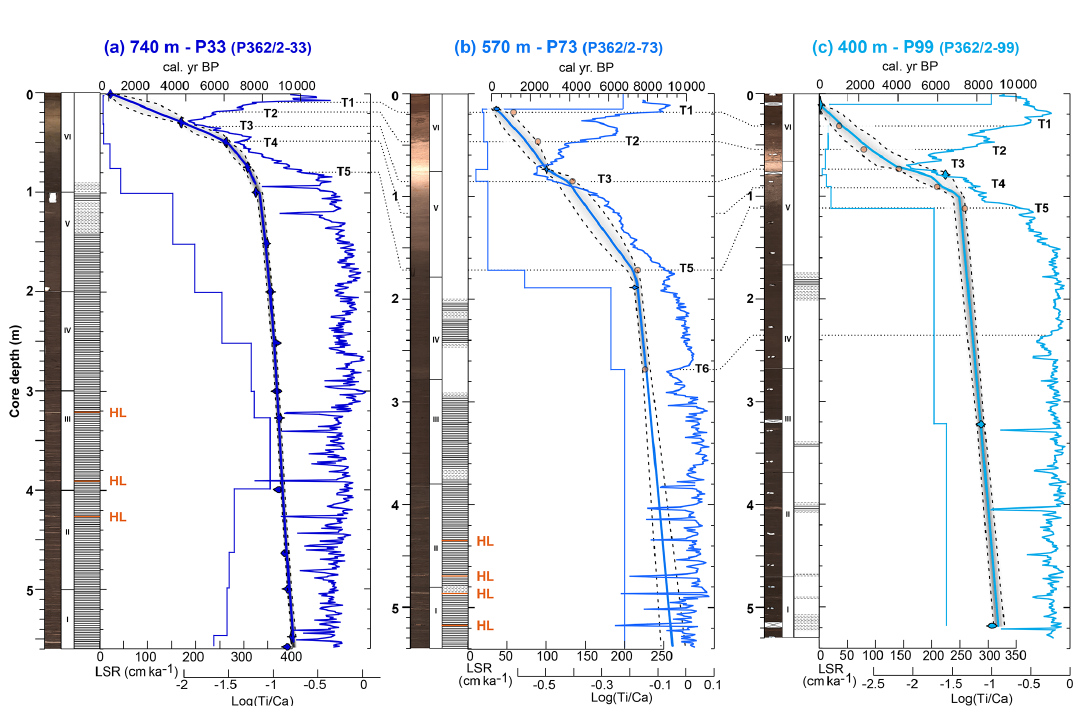
Figure 2. Age models: (a) core P33, (b) core P73 and (c) core P99. For all cores, from left to right: core depth (m), half-core surface images (for core P99, realized after sampling with empty sections shown as crosses), section number (roman numbers), schematic litholog- ical log (white: bioturbated; dashed: faint laminations; hatched: laminations; orange: hard layers labelled HL), linear sedimentation rates (cmka − 1 , step curves), age–depth relationships as computed by Bacon V2.3 (Blaauw and Christen, 2011) with radiocarbon ages (blue violin distributions) and tie points (orange dots), Log (Ti / Ca) records with tie points T1–T6 (dashed lines) (Table